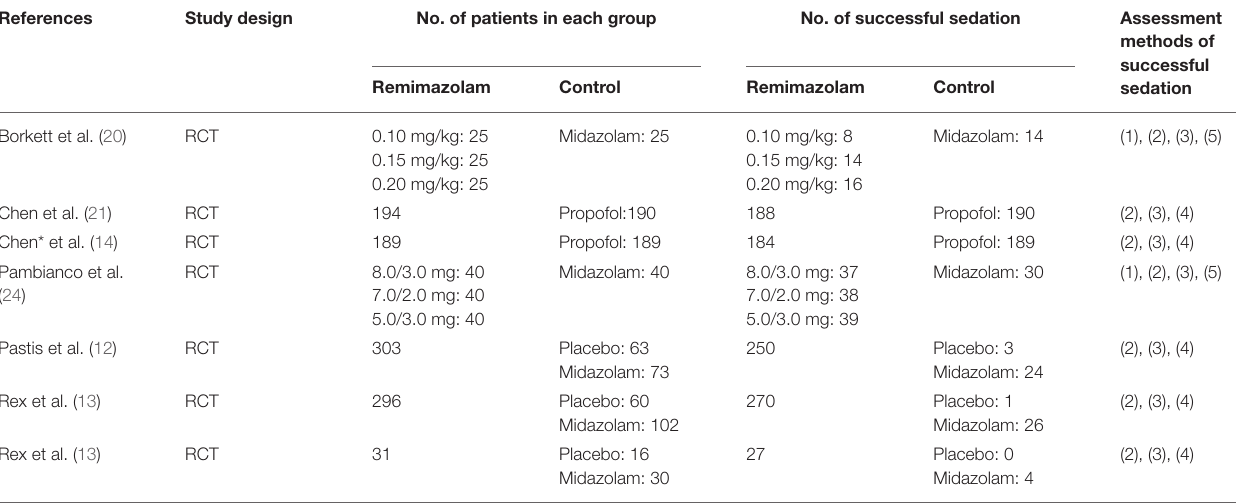
TABLE 2 | The number of patients with successful sedation and assessment methods of successful sedation in